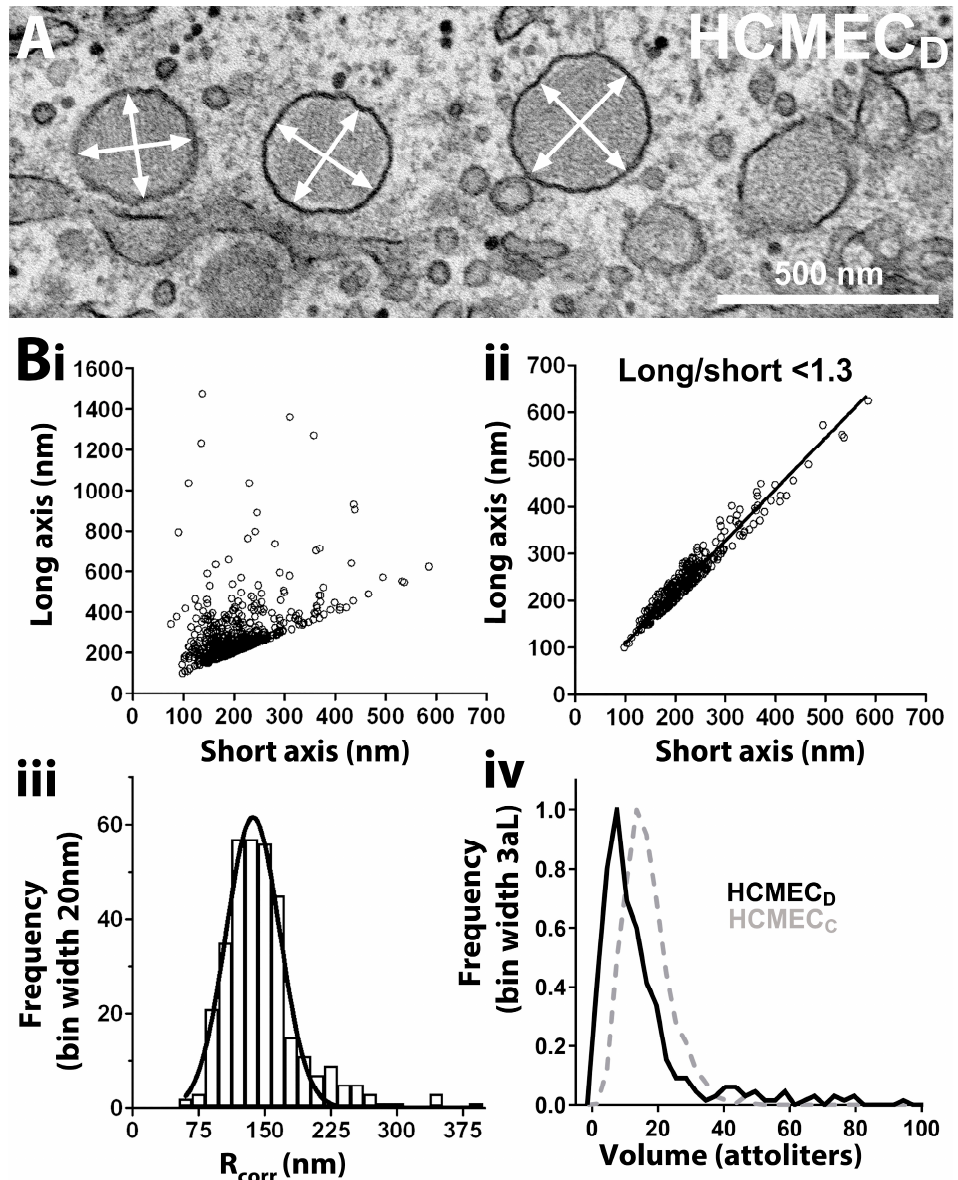
Figure 5. Estimated volumes for WPBs in HCMEC D and HCMEC C . ( A ) En-face thin section transmission electron micrograph of HCMEC D with rounded WPBs; white arrows indicate long or short axis of organelles. ( Bi ) Scatter plot of the long vs. short axis lengths of HCMEC D WPBs measured from electron micrographs (n = 54 EM images, 4 independent experiments) and ( Bii ), HCMEC D WPBs with a long:short axis ratio < 1.3 (i.e., approximately spherical in shape, 337/571 WPBs). ( Biii ) Histogram of the radius of HCMEC D WPBs in ( Bii ) corrected for non-diametric sectioning (R corr) . ( Biv ) Frequency histogram of the calculated volumes for WPBs in ( Bii , iii ). Dashed line in iv is the calculated volume distribution for rod-shaped WPBs in HCMEC C , determined as described in Section 4.3 (n = 1231 WPBs, 28 cells, 2 independent experiments). HCMEC; human cardiac microvascular endothelial cells ( C ; control, D ; dilated cardiomyopathy). WPBs; Weibel–Palade bodies.